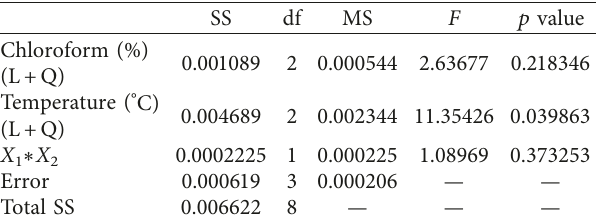
Table 4: Analysis of variance (ANOVA) of the regression pa- rameters for the Box–Behnken design used to determine the effects of chloroform and temperature on the enzymatic activity of extracted beta-galactosidase of Aspergillus orzyae CCT 0977.